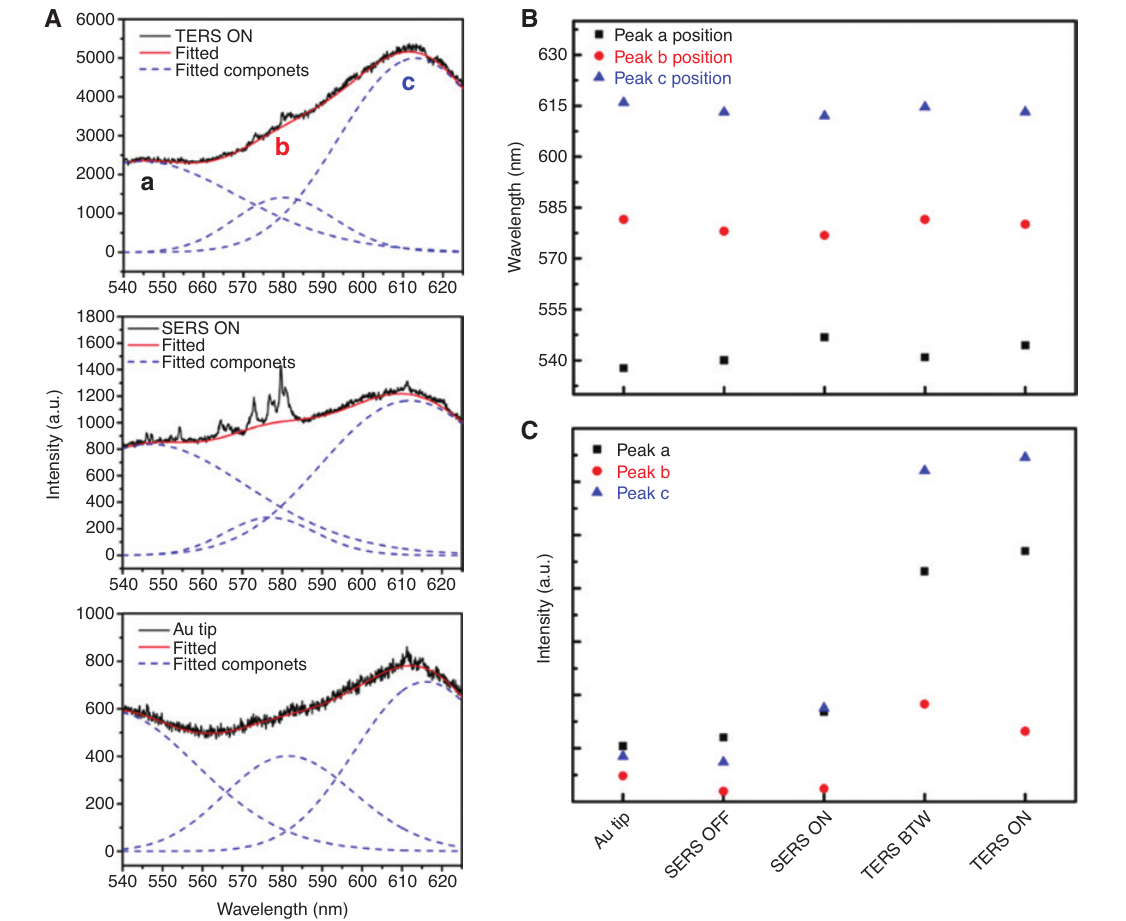
Figure 7: Analysis of the TERS spectra. (A) Analysis of spectral background from the tip alone (bottom), SERS at the Au nanodisks (middle), and TERS at the Au nanodisk (top) at 532 nm excitation. Black curves are the original spectra. The red curves are the sum of the fit. Three Gaussians (blue curves) with the maxima at around 540 nm (a), 580 nm (b), and 613 nm (c) are used to fit the spectral background. (B) Comparisons of the peak positions of a, b, and c, which are derived from the spectra of Au tip alone, SERS on film (SERS OFF), SERS on particle (SERS ON), TERS between the particle (TERS BTW), and TERS on the particle (TERS ON). (C) Comparisons of the peak intensities of a, b, and c. The detailed data analysis can be found in Supporting